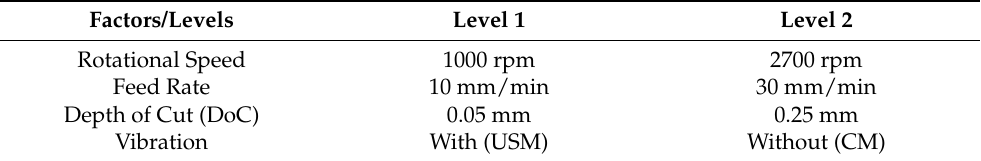
Table 4. Machining parameter levels of experiments.